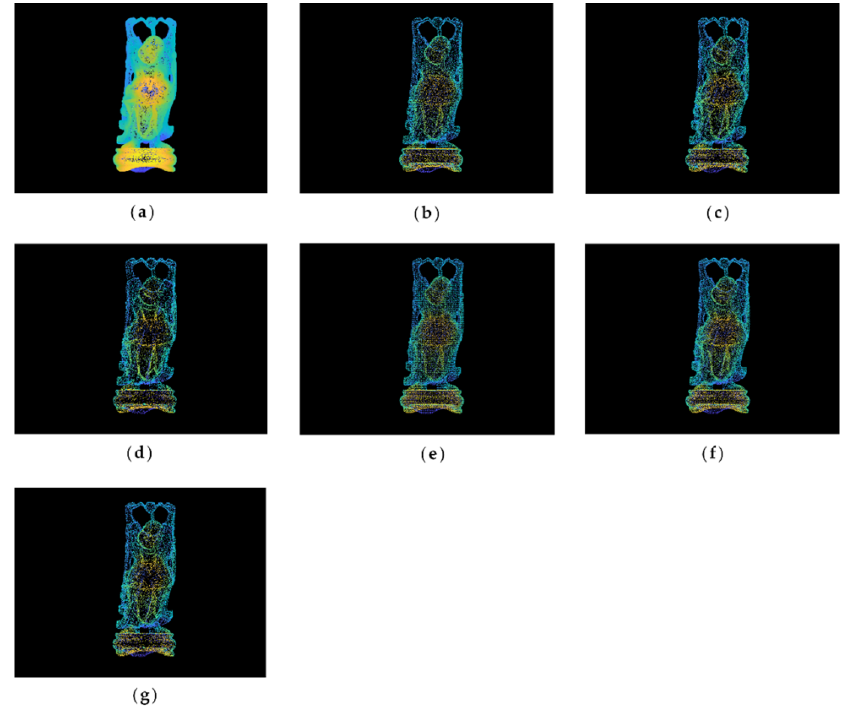
Figure 3. Original and simplified point clouds of the buddha dataset: ( a ) original point cloud; ( b ) MIWSA; ( c ) random algorithm; ( d ) normal algorithm; ( e ) voxel algorithm; ( f ) k-means